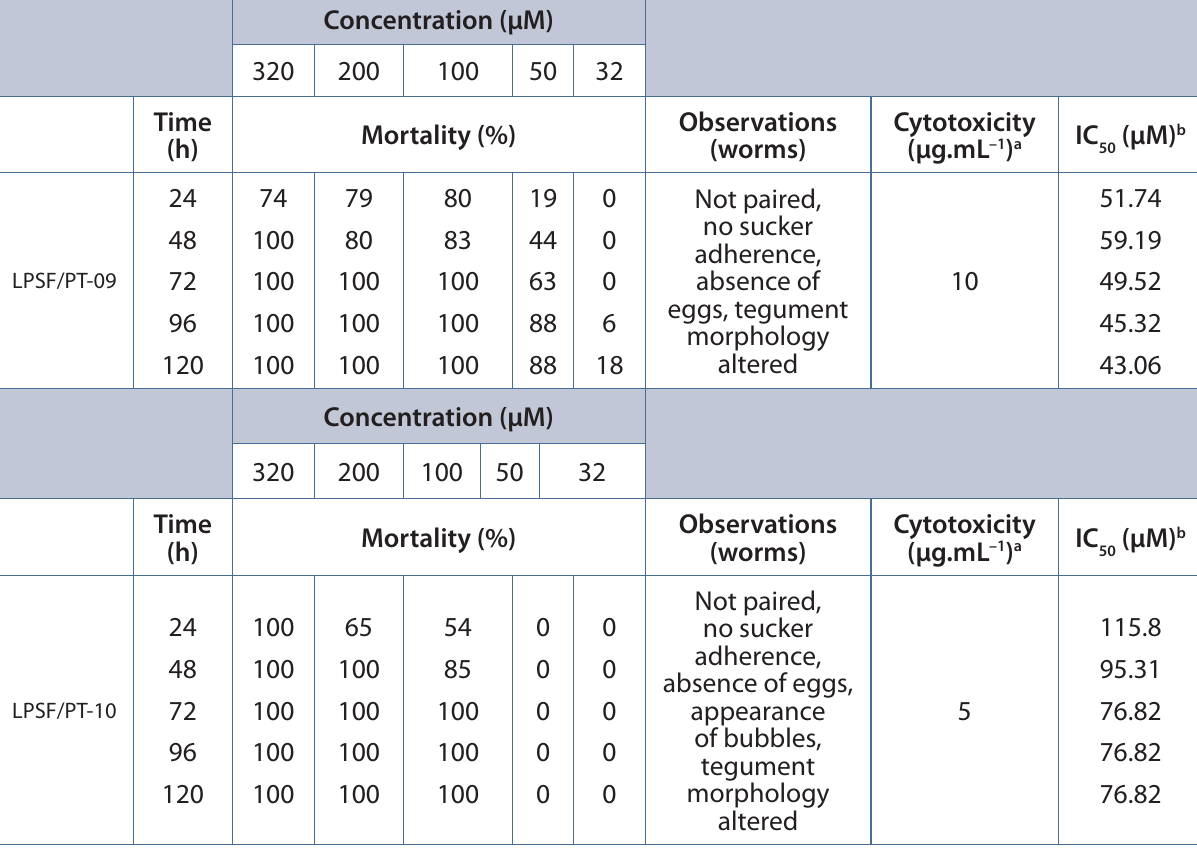
Table 1. In vitro effects of LPSF/PT-09 and LPSF/PT-10 against Schistosoma mansoni adult worms